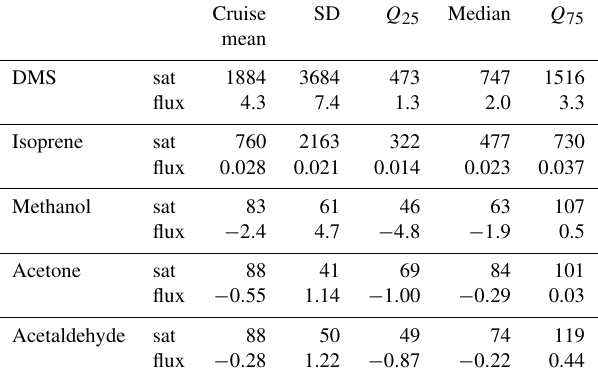
Table 3. Cruise mean saturation (%) and flux (µmolm − 2 d − 1 ). These calculations are only fluxes and saturations for which am- bient air and seawater measurements were both available during the same hourly measurement cycle. Saturations below 100% indicate undersaturation, and a negative flux indicates flux from the air into the ocean. Campaign median and quantiles ( Q 25 and Q 75 ) are also indicated as well as the standard deviation